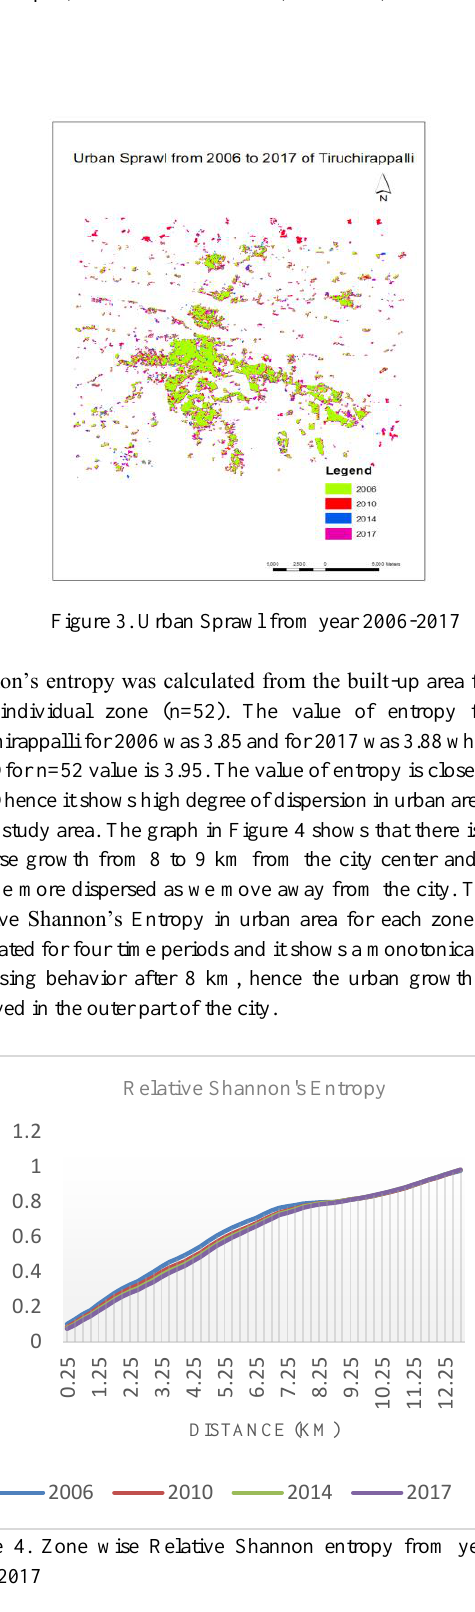
Figure 4. Zone wise Relative Shannon entropy from